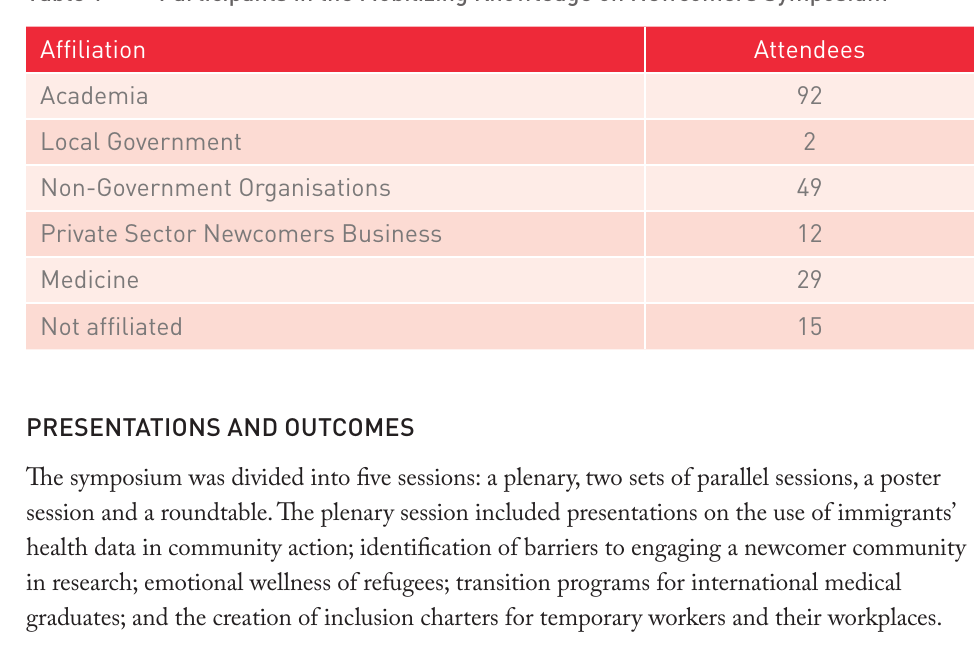
Participants in the Mobilizing Knowledge on Newcomers